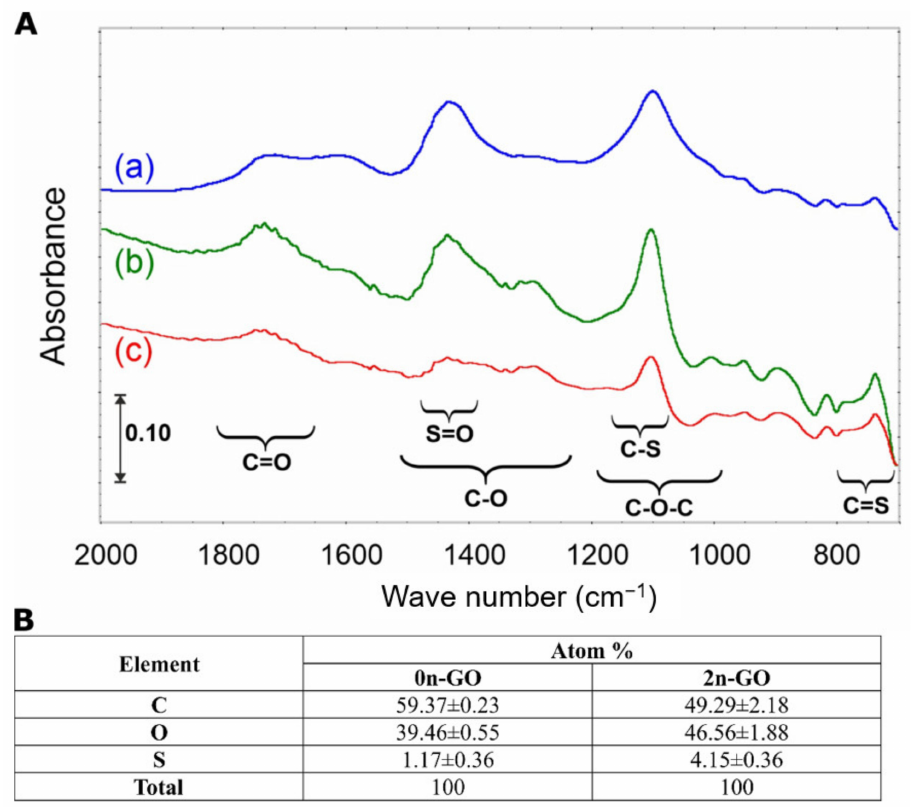
Figure 5. ( A ) Fourier transform infrared (FTIR) spectral changes registered during a 2-h size reduction process: (a) initial GO sample, (b) 2n-GO, and (c) differential spectrum. ( B ) The results from EDX measurements. Data are presented as the mean ± standard error of the mean (SEM). All differences in the elemental composition were statistically important with p <